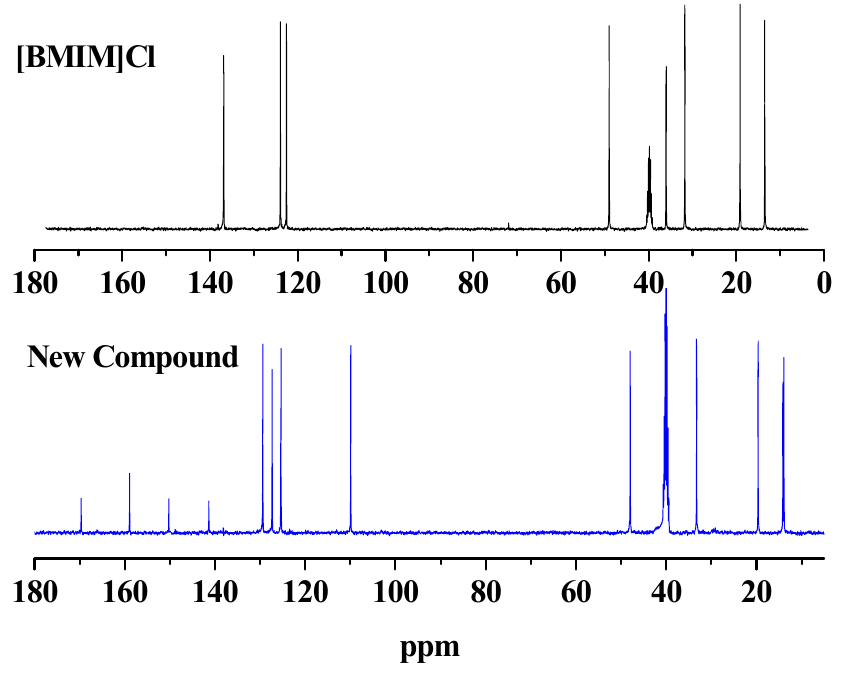
Figure 2. Comparison the 13 C-NMR spectra of [Bmim]Cl and the new compound in DMSO-d at 30 6